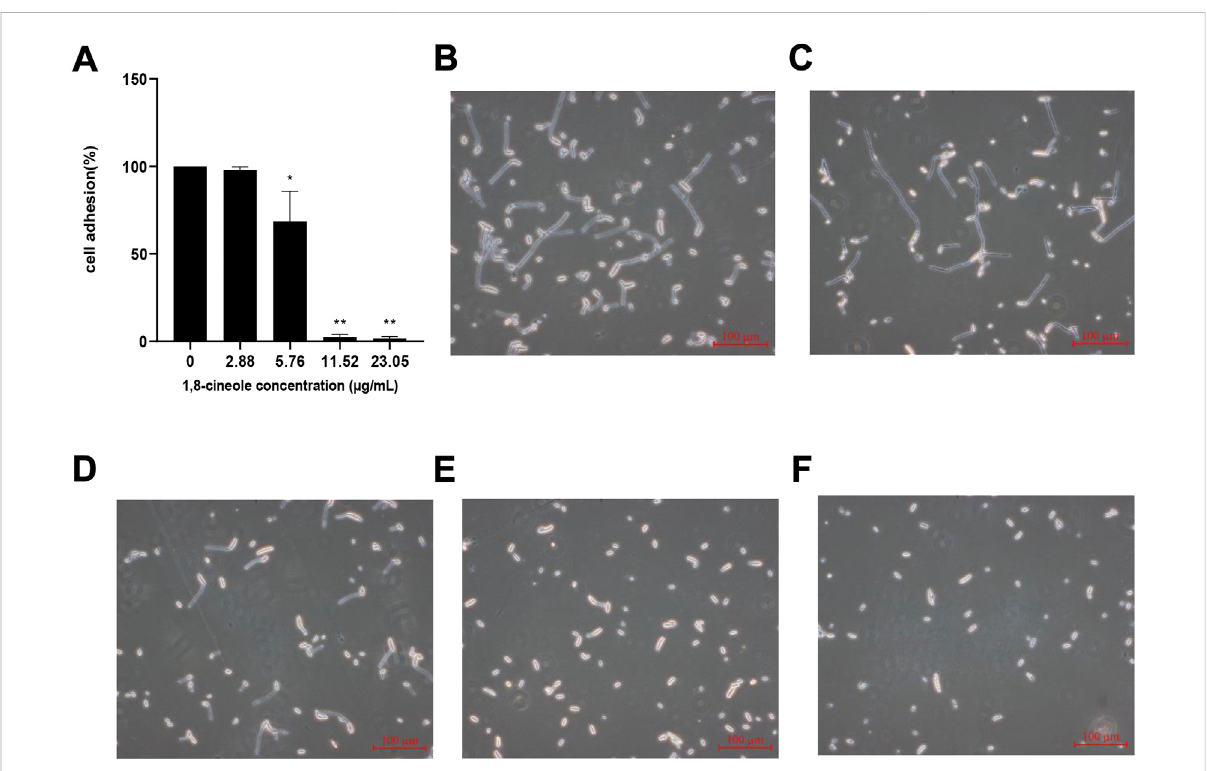
FIGURE 3 Effect of different concentrations of 1,8-cineole on adhesion and hypha formation. (A) Effects of different concentrations of 1,8-cineole on adhesion.Exponentiallygrowing F.solani speciescomplexcellsweretransferredtoRPMI1640mediawithdifferentconcentrationsof1,8-cineoleat 27 ° Cfor4 h.Inadhesionassay,exponentiallygrowing F.solani speciescomplexcellswereincubatedwithdifferentconcentrationsof1,8-cineolefor 4 handwasevaluatedusinganXTTreductionassay.(C~F)Effectsofdifferentconcentrationsof1,8-cineoleonhyphaformation.Exponentially growing F. solani species complex cells were transferred to RPMI 1640 media with different concentrations of 1,8-cineole at 27 ° C for 6 h. The group of control (B) and the concentration of 2.88 μ g/ml (C) , 5.76 μ g/ml (D) , 11.52 μ g/ml (E) , and 23.05 μ g/ml (F) 1,8-cineole, respectively. The results represent means ± standard deviations for three independent experiments. *, p < 0.05; **, p <